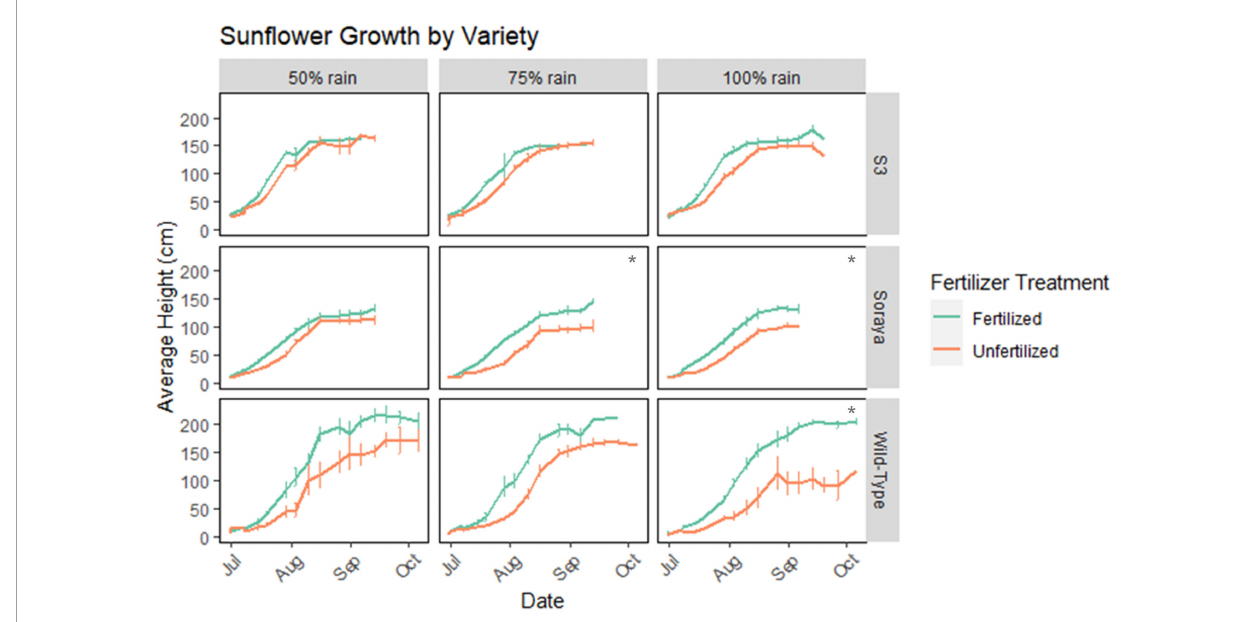
FIGURE3 Average height (cm) of three sunflower varieties in July–October of 2021. Height is averaged over three replicate treatments of each rainfall and fertilizer treatment. Each replicate plot contained 4 Soraya plants, 2–3 S3 plants, and 1–2 Wild-Type plants. Each *represents statistical difference ( p < 0.05) in average maximum height (cm) between fertilized vs. unfertilized plants. In all species, there was no significant difference in maximum growth between rain treatments. Error bars represent standard error.